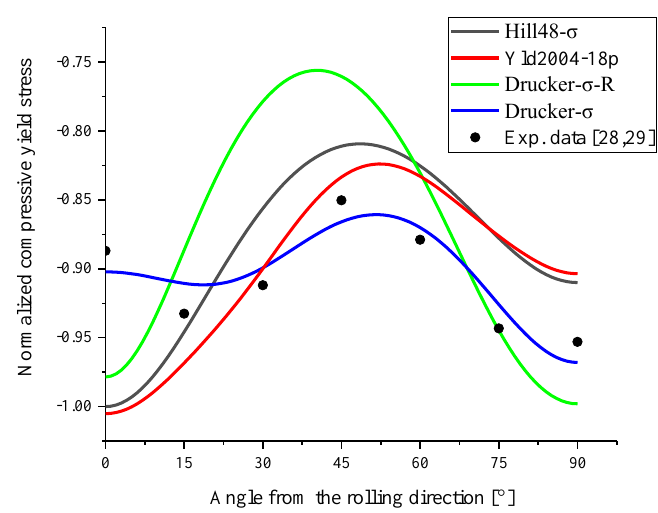
Figure 4. The normalized compressive yield stresses with four yield functions for AA 2090-T3 sheet.